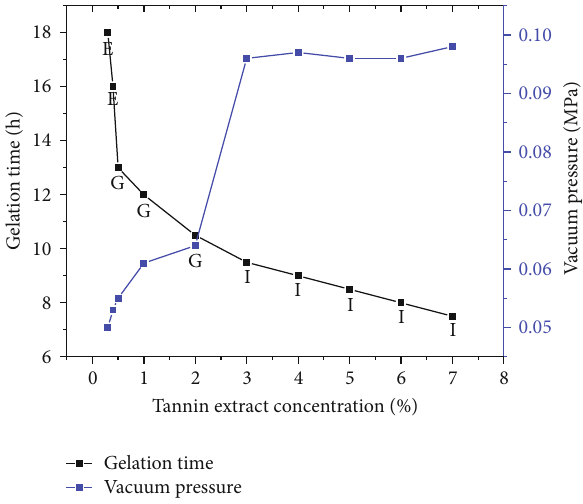
Figure 9: Single-core physical experiment fl ow chart.